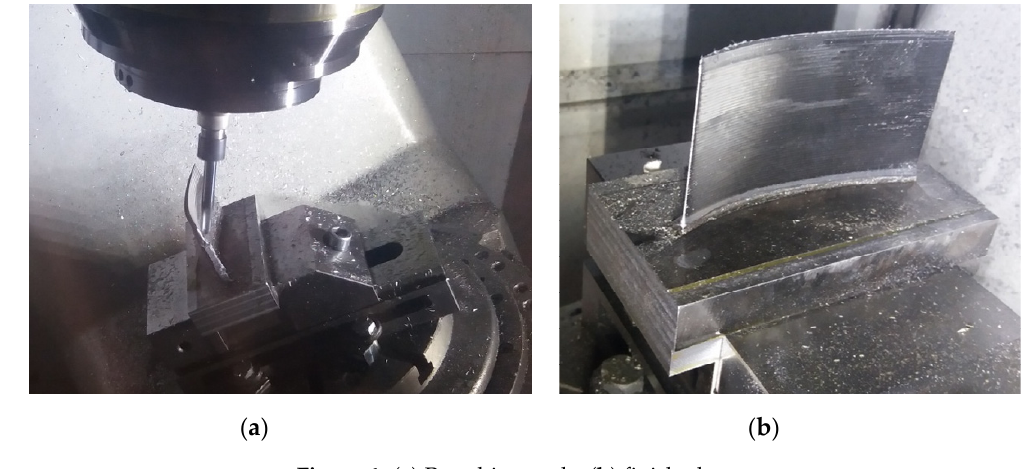
Figure 4. ( a ) Roughing cycle, ( b ) finished part.